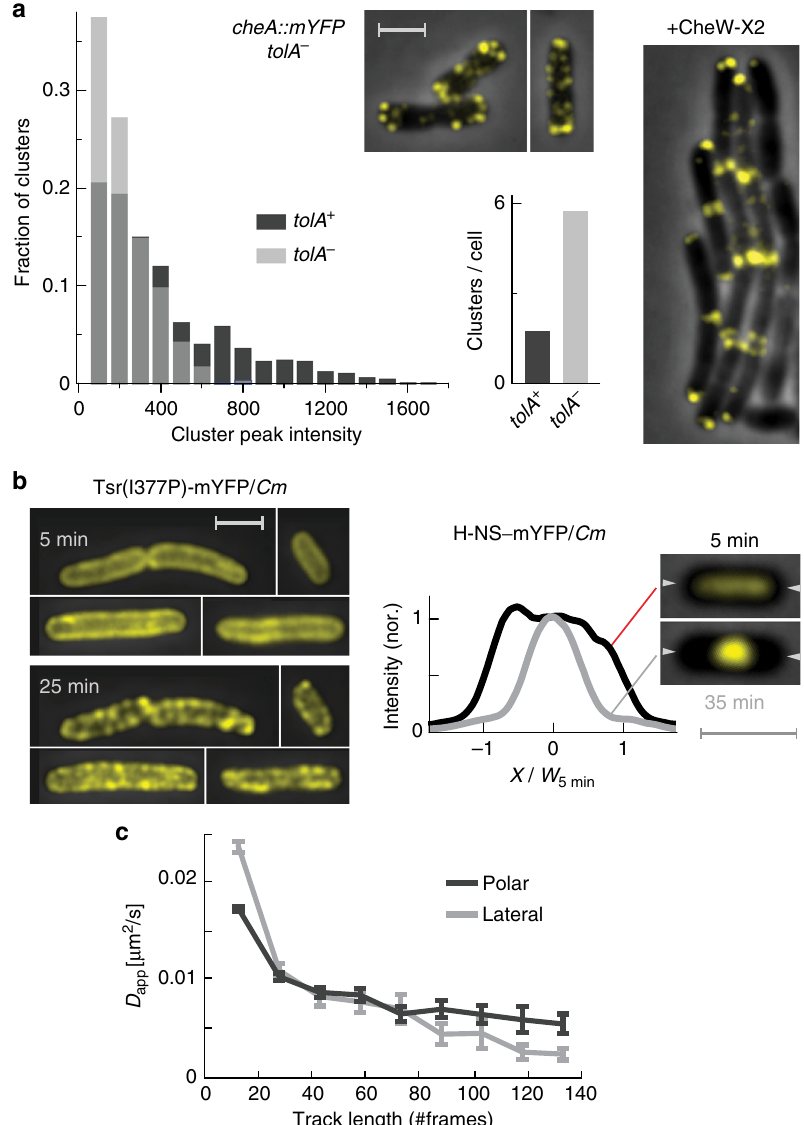
Fig. 6 The effect of altered membrane environments on receptor clusters. a Effect of TolA. Distribution of cluster intensity in cheA::mYFP cells with (MK4; dark gray) or without (MK13; light gray) TolA. A total of 472 clusters (in 264 cells) or 475 clusters (in 82 cells) were sampled from each strain, respectively. Fluorescence images of typical TolA − cell is also shown. The fl uorescence image on the right demonstrate polar bias in TolA − cells in which CheW-X2 was also expressed from a plasmid using 1 µ M NaSal (see also Supplementary Fig. 7). b Left: Δ (cheA cheW MCPs ) (UU2806) cells expressing Tsr (I377P)-mYFP receptors and imaged at various times after exposure to Cm (20 µ g/ml). Right: UU2806 cells expressing H-NS-mYFP (pAV357, induced by 2 µ M IPTG) and imaged at various times after exposure to Cm (20 µ g/ml). Corresponding intensity pro fi les measured along the long axis of the cell (between the marks) are also shown. See also Supplementary Fig. 8. Scale bars correspond to 2 µ m. c Mobility of receptor complexes in the polar (dark gray) and lateral (light gray) cell regions measured using LPA-SPT (with frame repetition time of 320 ms). The mean (±s.e.m.) mobility (apparent diffusivity, D ) of clusters in each track-length bin (bin size = 15 frames) is shown. Track length serves as a proxy for cluster size (see